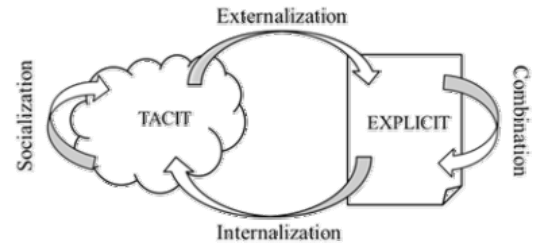
Figure 1. Model of Knowledge Conversion according to Nonaka and